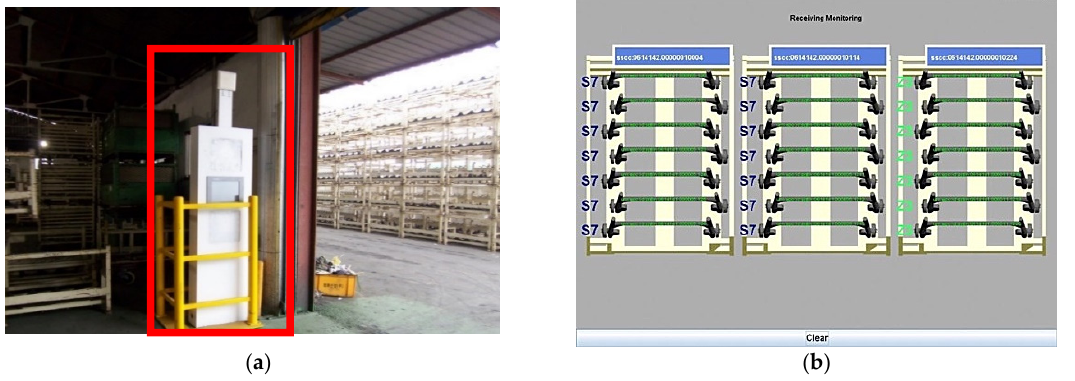
Figure 8. The receiving process at the consolidation center. ( a ) Read point at receiving area; ( b ) Screen shot of receiving application.